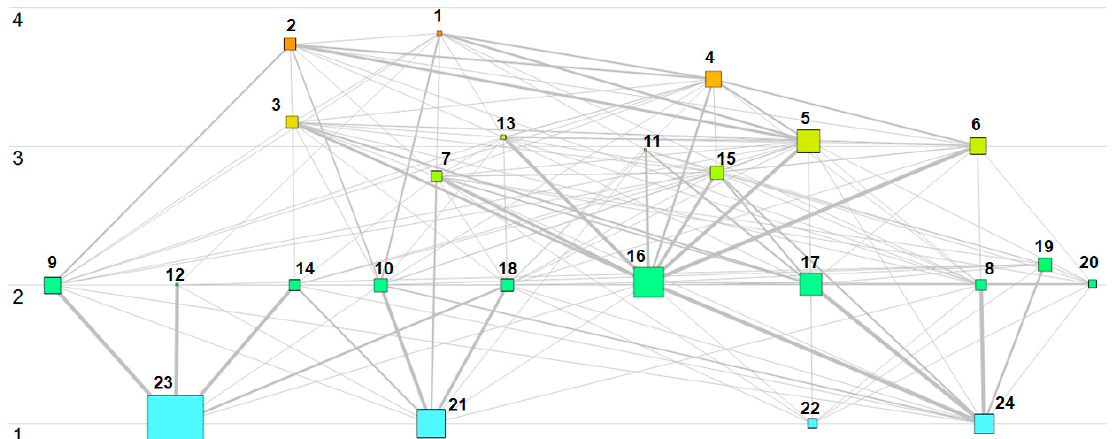
Figure 2. Trophic flow diagram of the Dongsha seagrass bed model. The area of each compartment represents the proportion of the total biomass of the model contained by the compartment. The line between each compartment represents the trophic relationship between them. Line width represents the relative flux between compartments. The numerical legend for compartments is: 1. pelagic sharks; 2. lemon sharks; 3. ray; 4. piscivorous fish; 5. large carnivorous fish; 6. small carnivorous fish; 7. omnivorous fish; 8. detritivorous fish; 9. seagrass herbivorous fish; 10. algae herbivorous fish; 11. hawksbill turtles; 12. green turtles; 13. cephalopods; 14. urchins; 15. carnivorous invertebrates; 16. omnivorous invertebrates; 17. filter invertebrates; 18. herbivorous invertebrates; 19. cnidarians; 20. zooplankton; 21. macroalgae; 22. microalgae; 23. seagrasses; and 24. detritus.